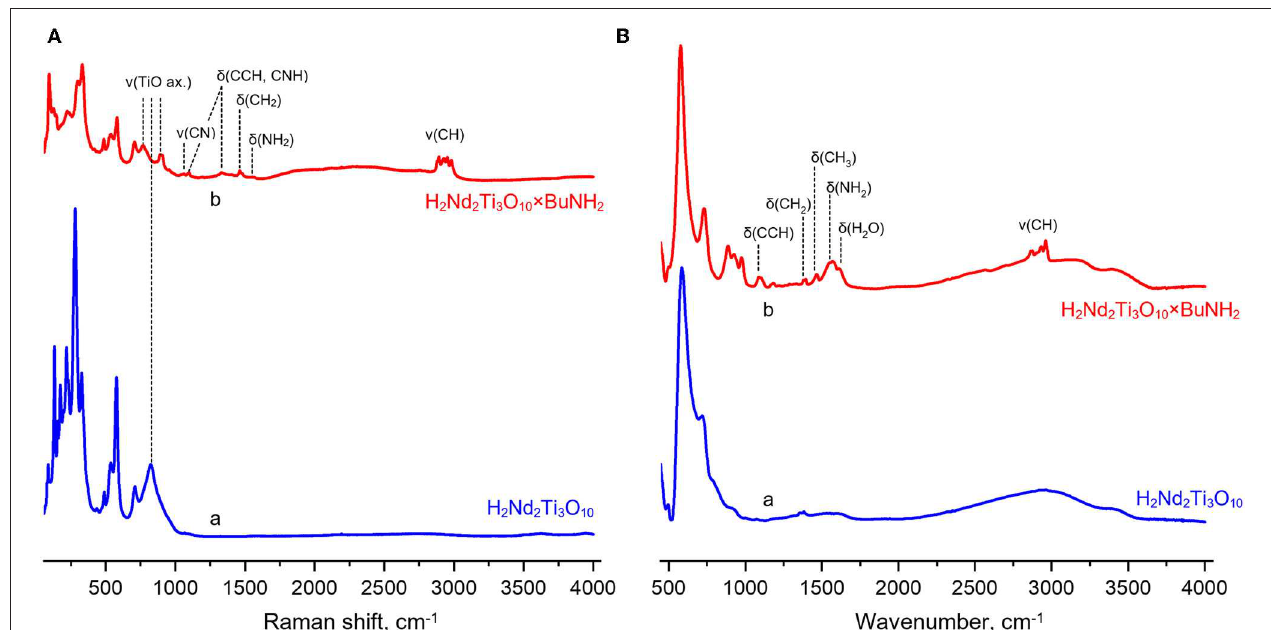
FIGURE 6 | Raman (A) and infrared (B) spectra of the protonated titanate H 2 Nd 2 Ti 3 O 10 (a) and its butylamine-intercalated form H 2 Nd 2 Ti 3 O 10 × BuNH 2 (b).